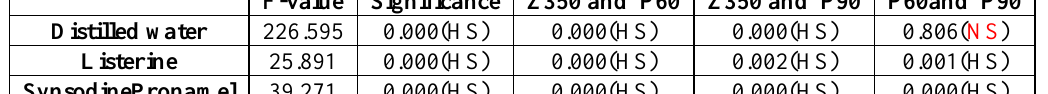
Table 5:ANOVAand LSDtests among the three tested material against each treatment solution F-value